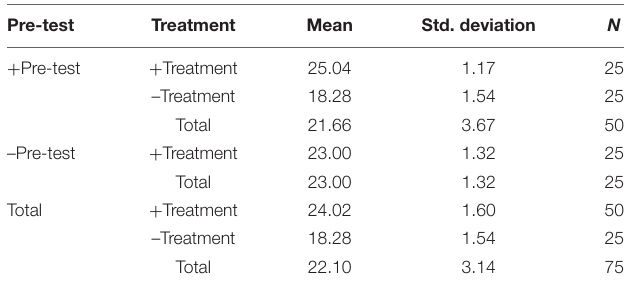
TABLE 4 | Descriptive statistics for comparing the effects of ± treatment and ±